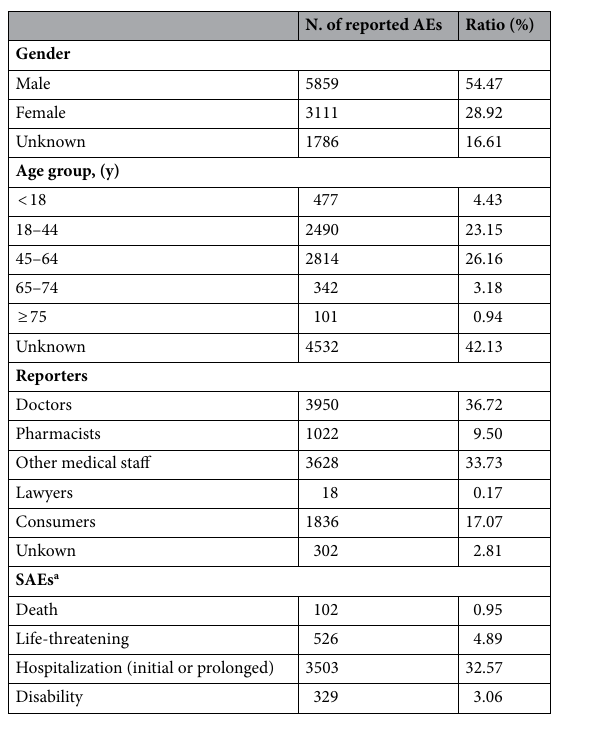
Table 1. Characteristics of adverse event reports submitted for darunavir and its boosted agents. a Serious adverse